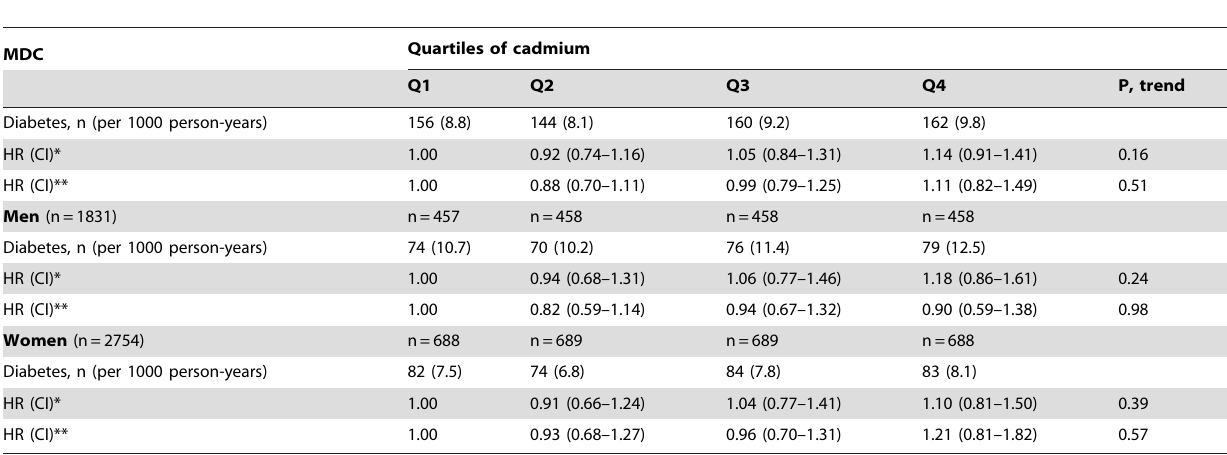
Table 2. Incidence of diabetes in relation to quartiles of blood cadmium concentrations at baseline in middle-aged men (n=1831) and women